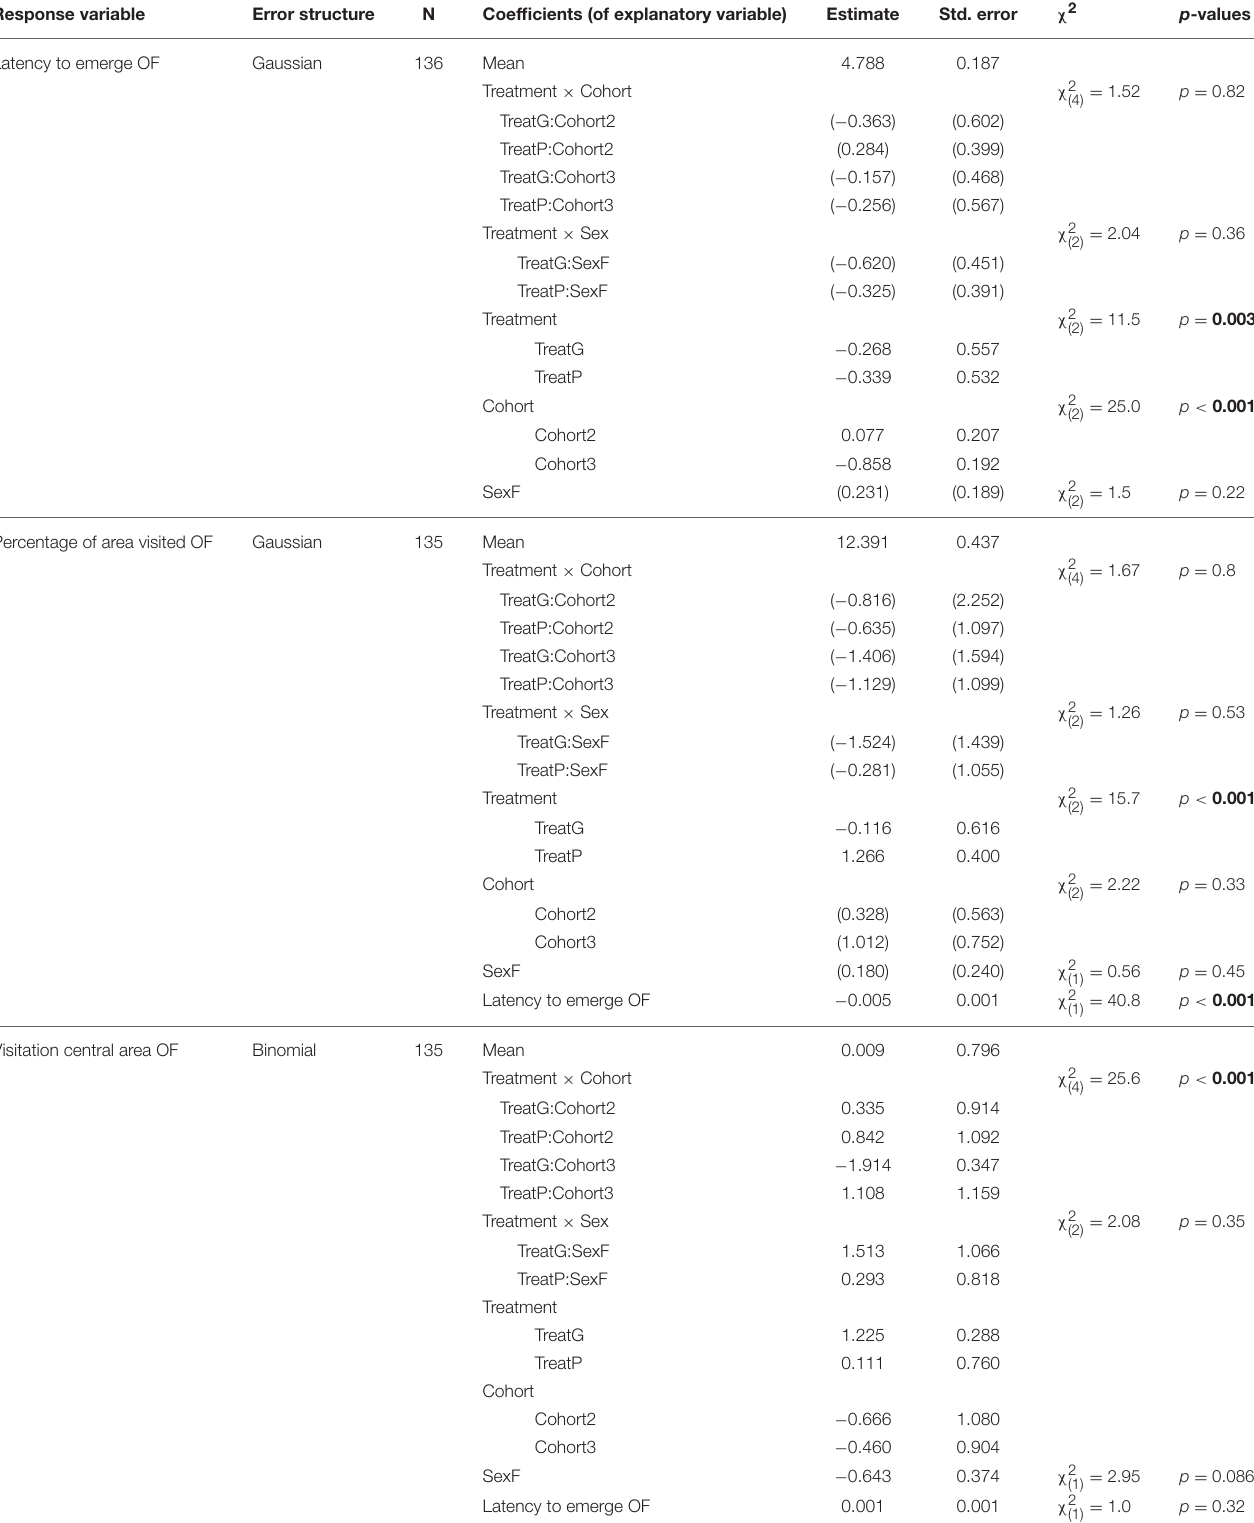
TABLE 3 | Model outputs (GEEs) indicating effects on the mean level behavior shown in an open field test (OF) and a novel object test